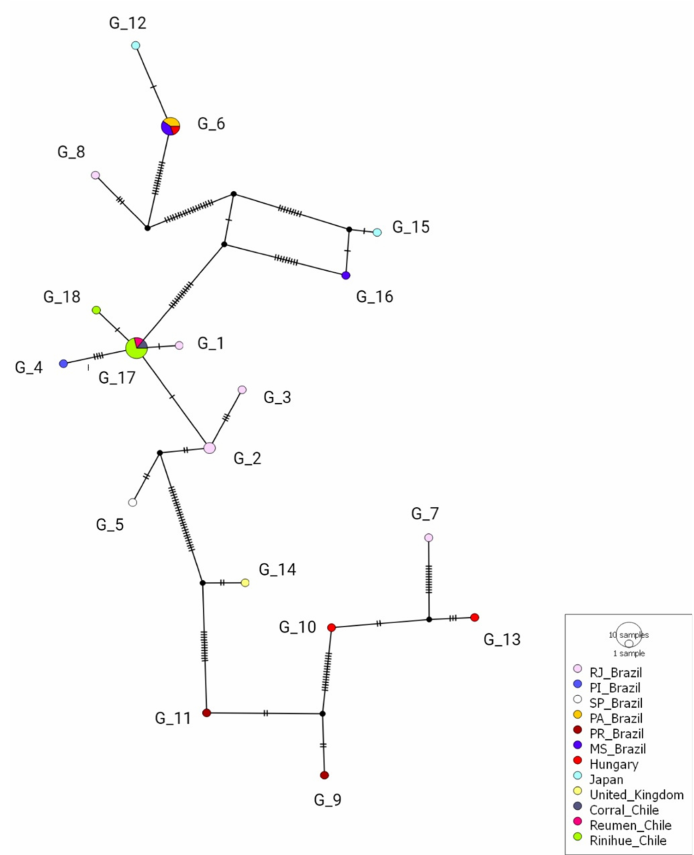
Figure 4. Genotype network for Mycoplasma spp. 16S rDNA sequences detected in rodents from the Valdivia province, Chile (genotypes #17 and #18), combined with hemoplasma sequences that were previously detected in Rodentia worldwide. Each small dash represents mutations. Dark circles represent median vectors. The genotype network was generated with DNAsp data followed by analysis in PopArt using geographic coordinates and a TCS network.